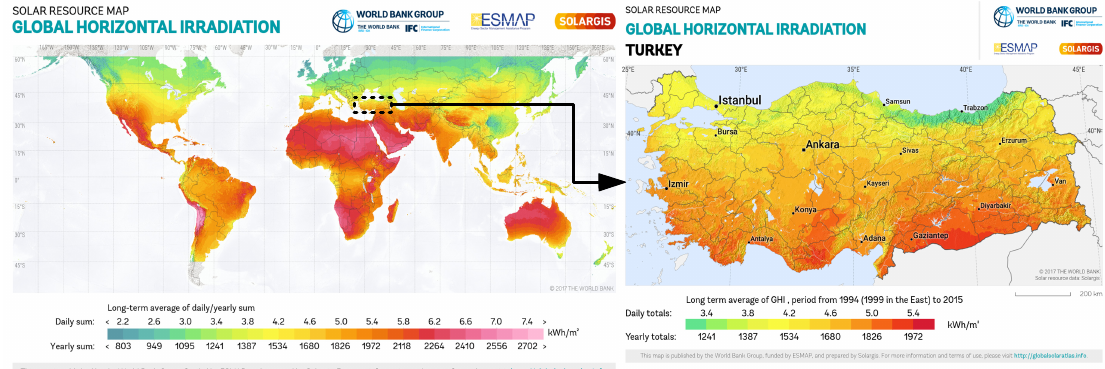
Figure 4. Global horizontal irradiation maps that exist in [29] for the Earth and Turkey.